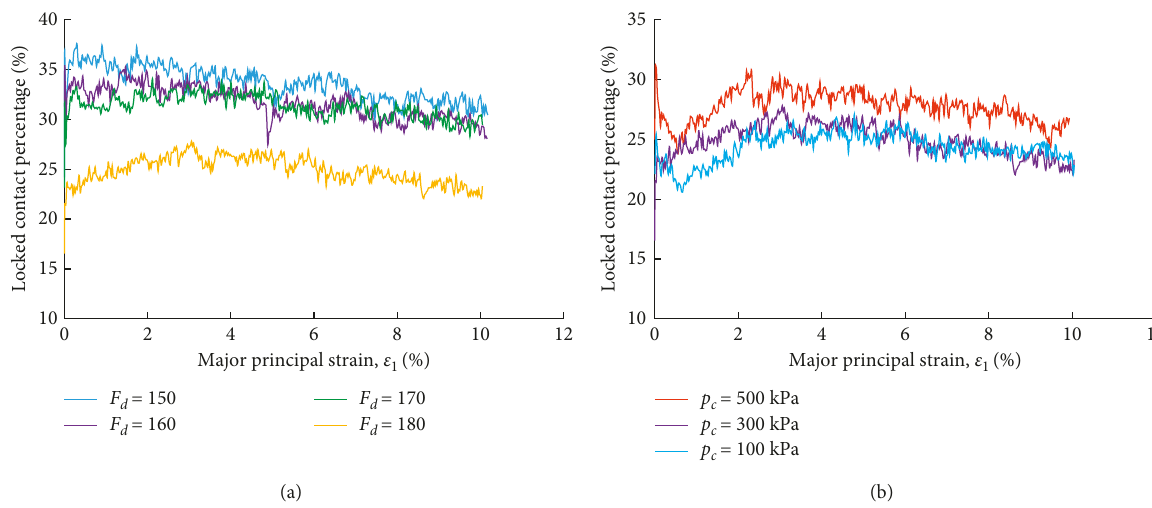
Figure 20: Variation in the locked contact percentage with major principal strain. TC tests: (a) p